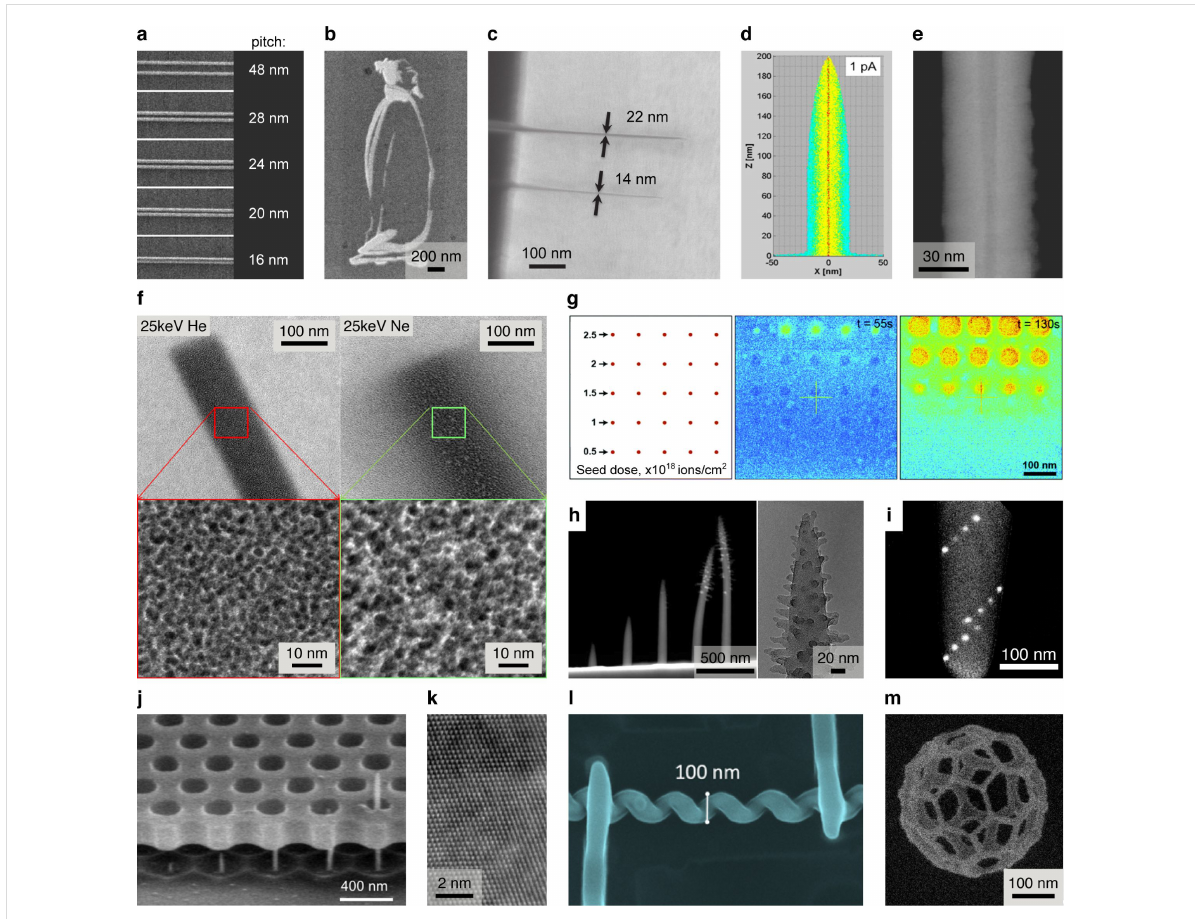
Figure 7: Examples of helium and neon FIBID. (a) Platinum-based line deposits fabricated using helium FIBID demonstrating a half-pitch down to 8 nm. Adapted with permission from Cambridge University Press, [232], Scipioni et al., A Design-of-Experiments Approach to Characterizing